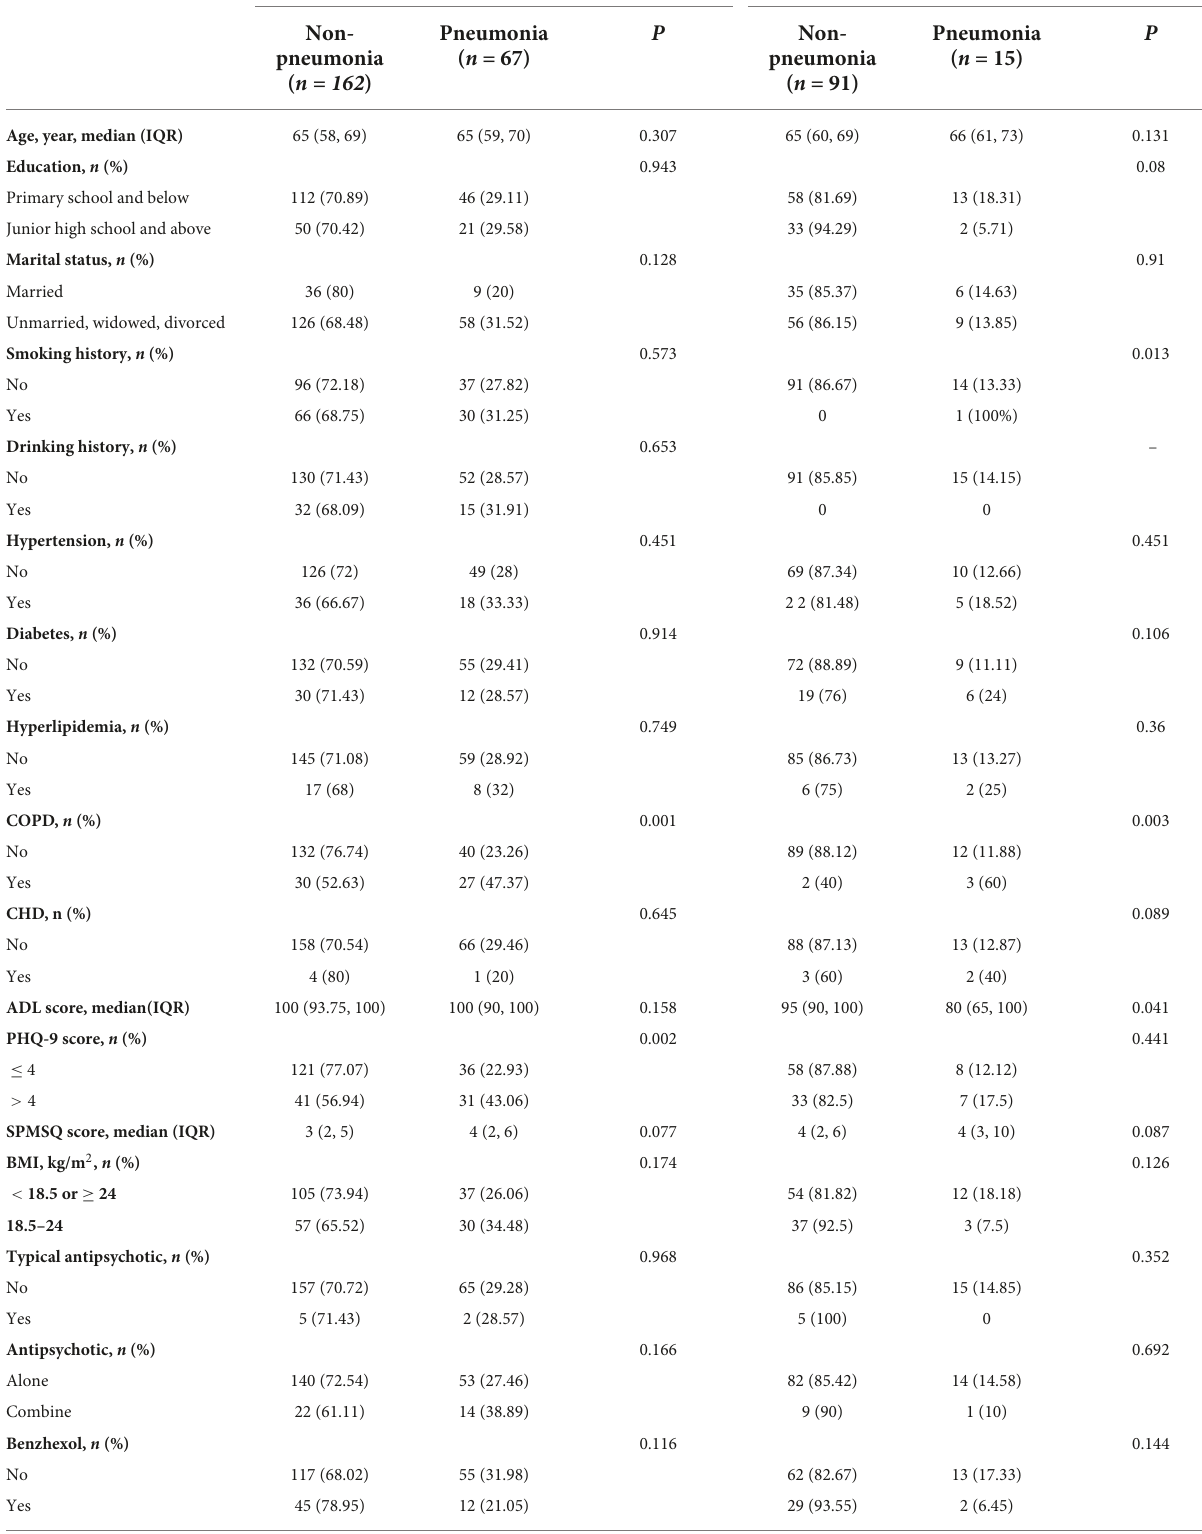
TABLE 1 Characteristics of the